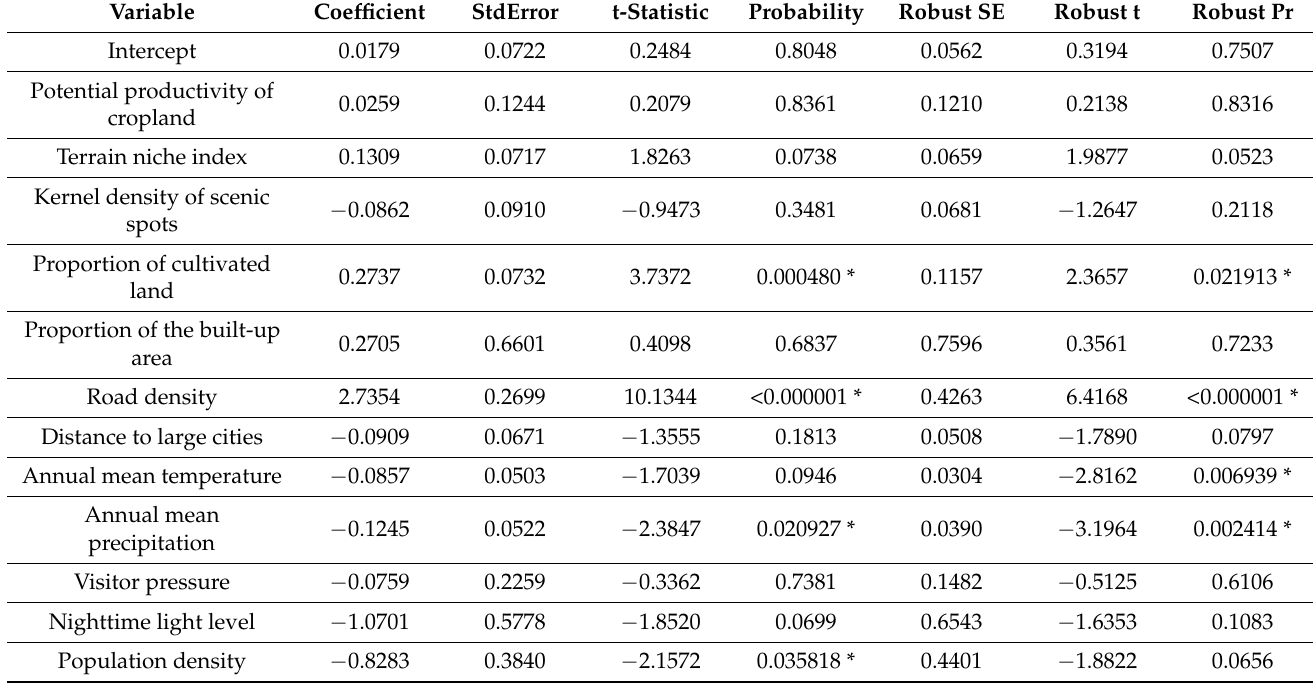
Table 3. The results of the OLS model including the PD and 12 selected independent variables.